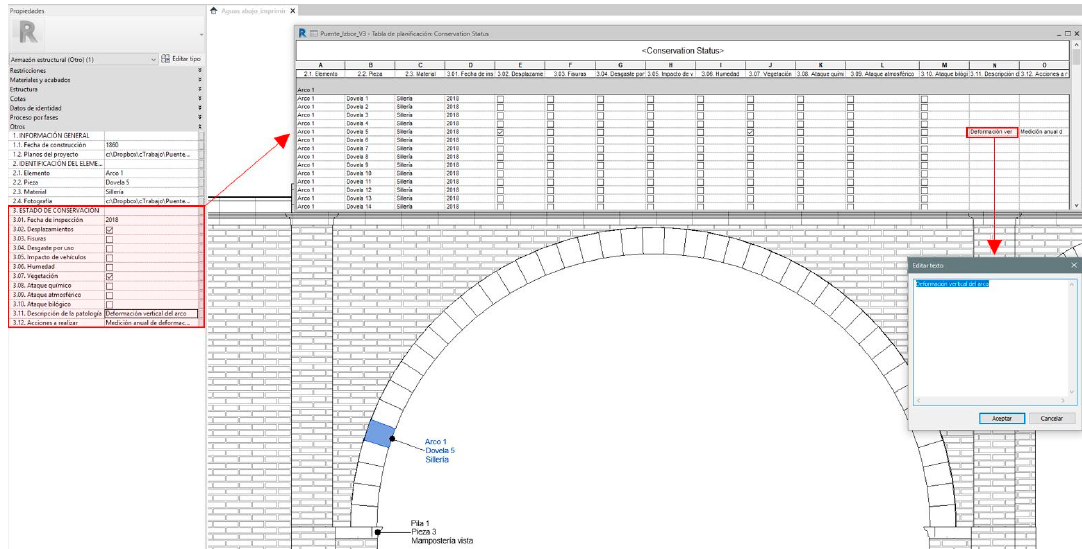
Figure 11. Inventory of the conservation states of the pieces.